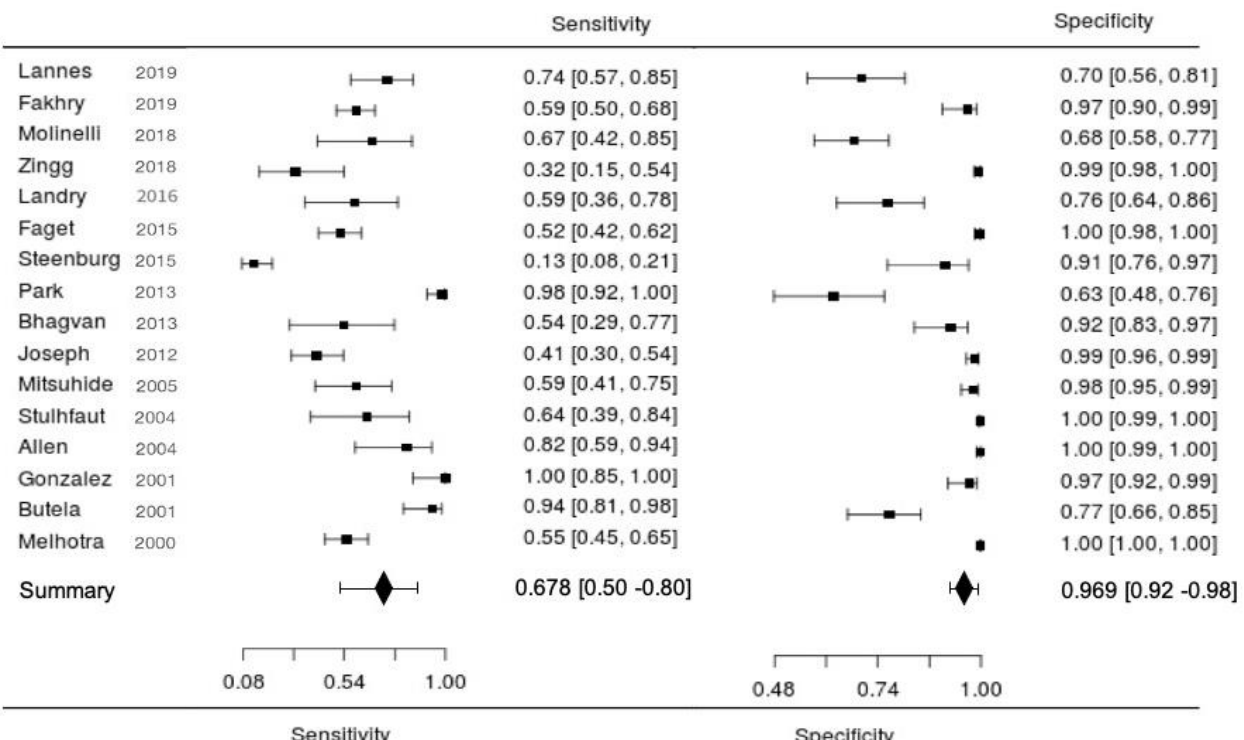
Figure 3. Forest plots of the sensitivity and specificity of computed tomography for the diagnosis of traumatic hollow viscus injuries.